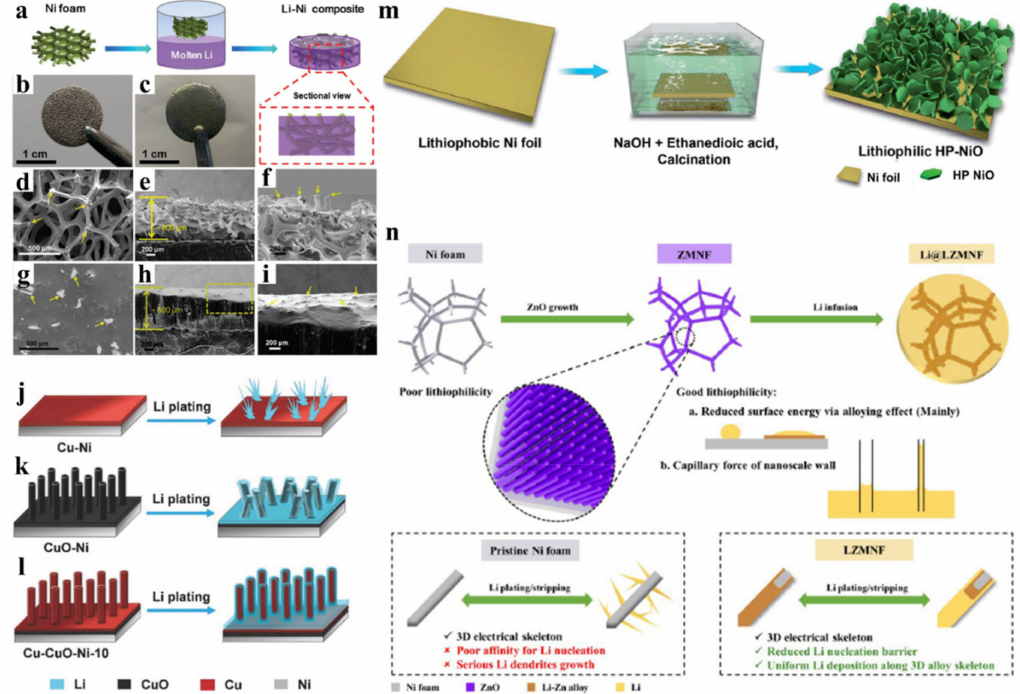
Figure 4. Lithiophilic behavior on the Ni-based porous framework. ( a – i ) Fabrication of the Li-Ni composite. Reproduced with permission from [55], John Wiley and Sons, 2017. ( j – l ) The schematic representation of Li plating on Cu-Ni, Cuo-Ni, and Cu-CuO-Ni. Reproduced with permission from [66], John Wiley and Sons, 2018. ( m ) Schematic illustration of HP-NiO sheets’ growth on Ni foil. Reproduced with permission from [59], Royal Society of Chemistry, 2019. ( n ) The schematic illustration of lithiophilic ZnO NA modified Ni foam (ZMNF) growth and its advantages. Reproduced with permission from [62], Royal Society of Chemistry,